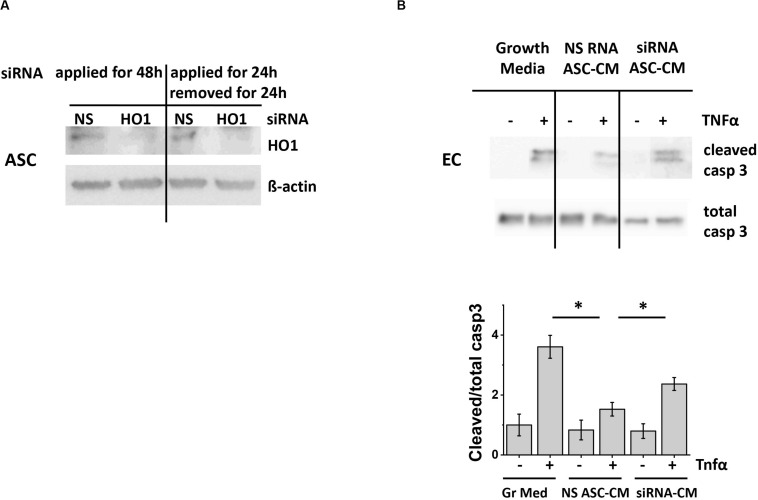
ASC with suppressed heme oxygenase 1 expression generate ASC-CM with reduced apoptosis-protective potency. (A) Left: ASC were treated continuously with 50 nM of non-specific (NS) or heme oxygenase 1 (HO-1)-specific siRNA for 48 h. Right: Treatment was applied for 24 h, followed by a 24 h incubation in siRNA-free media. Cell lysates were analyzed with antibodies to heme oxygenase 1 and β-actin (loading control). (B) ASC-CM was generated from ASC treated for 24 h with 50 nM non-specific RNA (NS RNA) or heme oxygenase 1-specific siRNA (siRNA), followed by siRNA removal and 24 h conditioning with media. HPAEC pre-incubated for 48 h with growth media or ASC-CM were stimulated with 2 ng/ml TNF. Cell lysates were analyzed with antibodies to cleaved and total caspase 3. Data from three independent experiments were pooled and presented as cleaved/total caspase 3 ratio mean ± SEM. ∗Significance between TNF-stimulated groups assessed by t-test with Welch’s correction as indicated (p < 0.05).